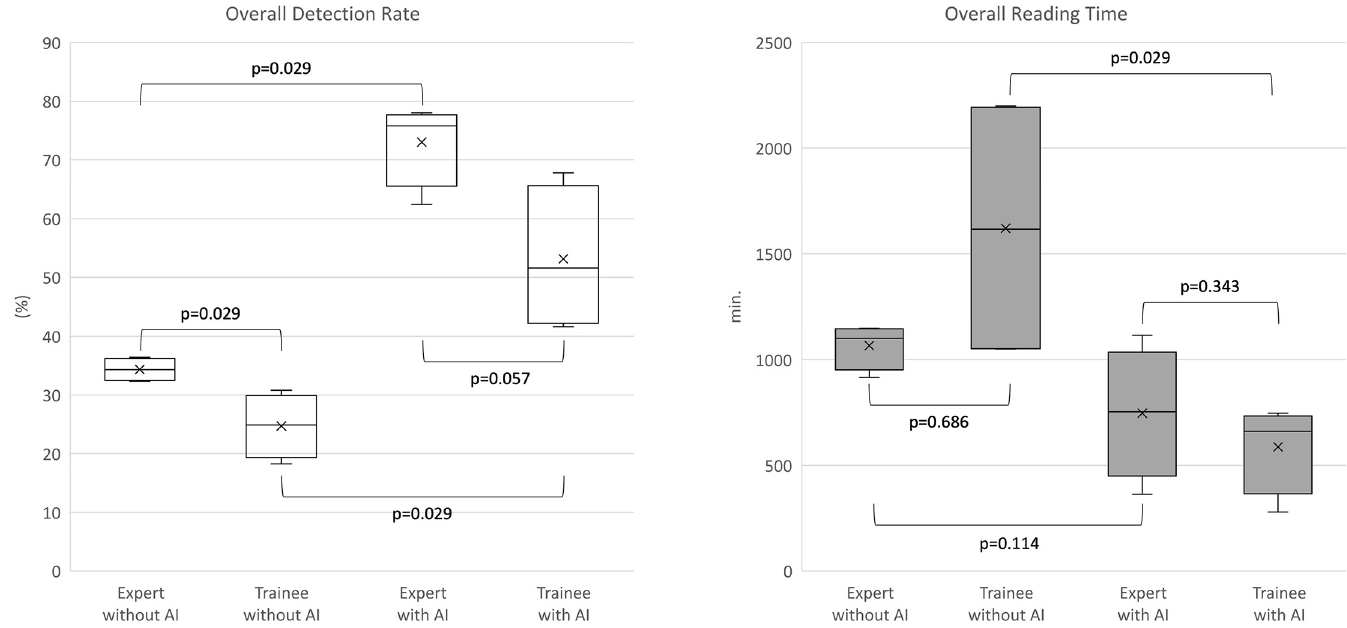
Fig 5. Improvement in the capsule endoscopy reading using the AI-assisted reading